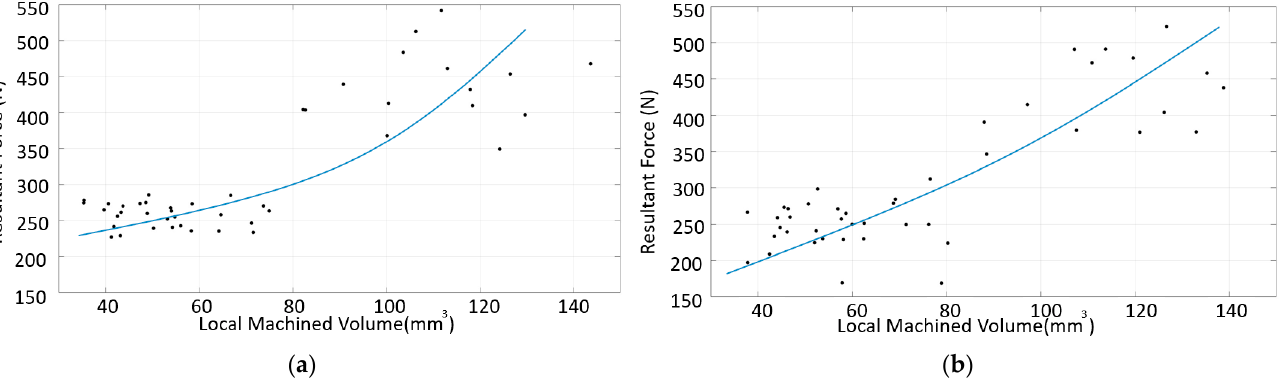
Figure 19. Resultant force vs. volume for the down-milling of the multi-material component with ( a ) SS machined and ( b ) CRS machined.